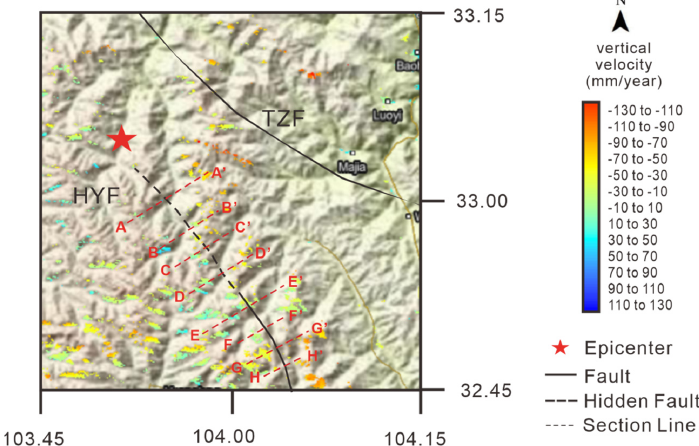
Figure 19. The annual average deformation rate field of the Huya fault.